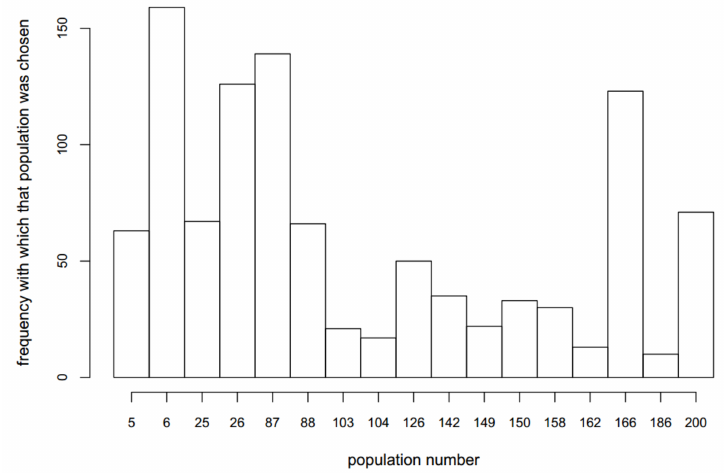
Figure 4. Frequency with which each population was observed in the 190 optimal sets of populations when optimality is defined as capturing all